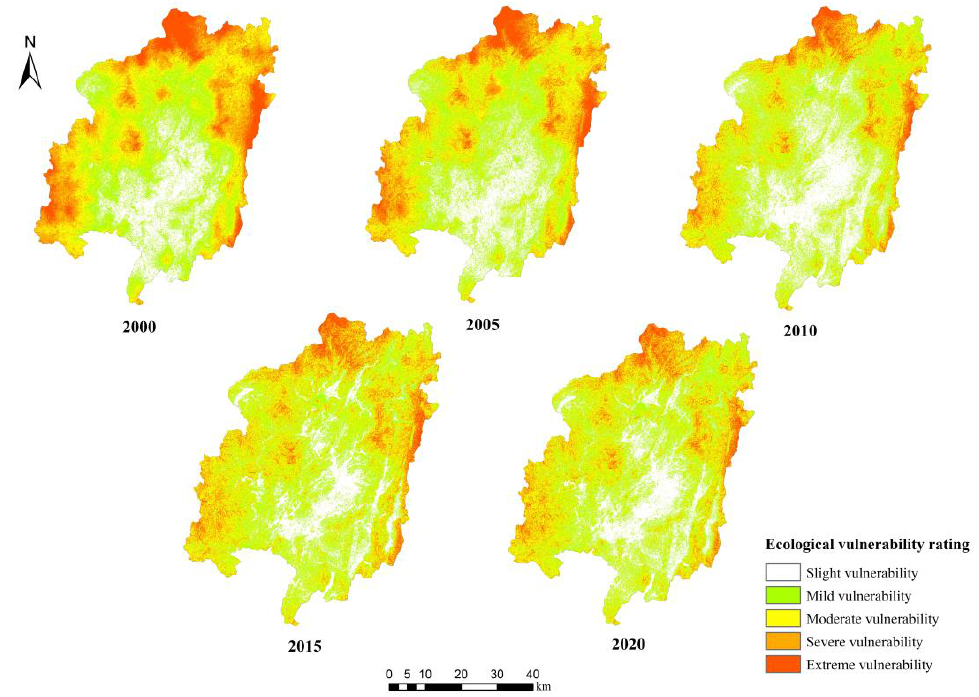
Figure 2. Spatial distribution of ecological vulnerability in red soil erosion area of Changting from 2000 to